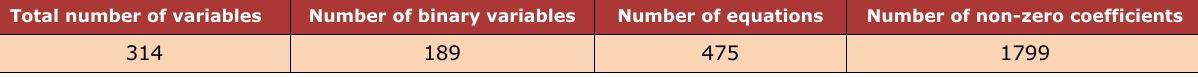
Table 14. The size of proposed mixed integer